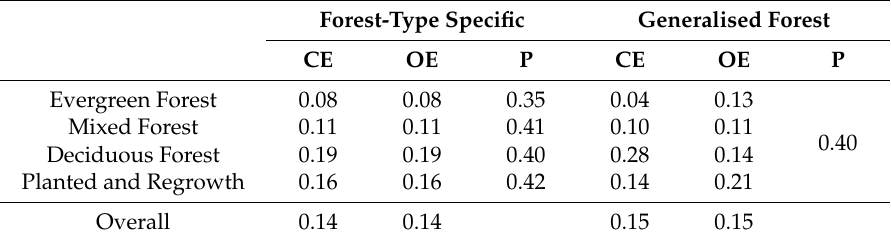
Figure 6. Overall forest clearance commission ( a ) and omission ( b ) errors using the generalised forest model (GM) and how this error is distributed among the four forest types within the generalised model (FT-GM). Error rates for the generalised model are shown on the x-axes, and are an average of error within each forest type shown on y-axes. The vertical dashed line represents the point where overall error for the generalised model is balanced at 0.15. The generalised model’s predicted probability of clearance is provided as an additional x-axis, and marked at a threshold where the overall error is balanced. Table 2. Forest clearance commission errors (CE) and omission errors (OE) for different forest types using forest-type specific models and the generalised forest model. The example presented chooses probability thresholds (P) with the goal of balancing commission and omission error. Data for the table are illustrated as points in Figures 5 and 6. Errors and probabilities are rounded to two decimal places.